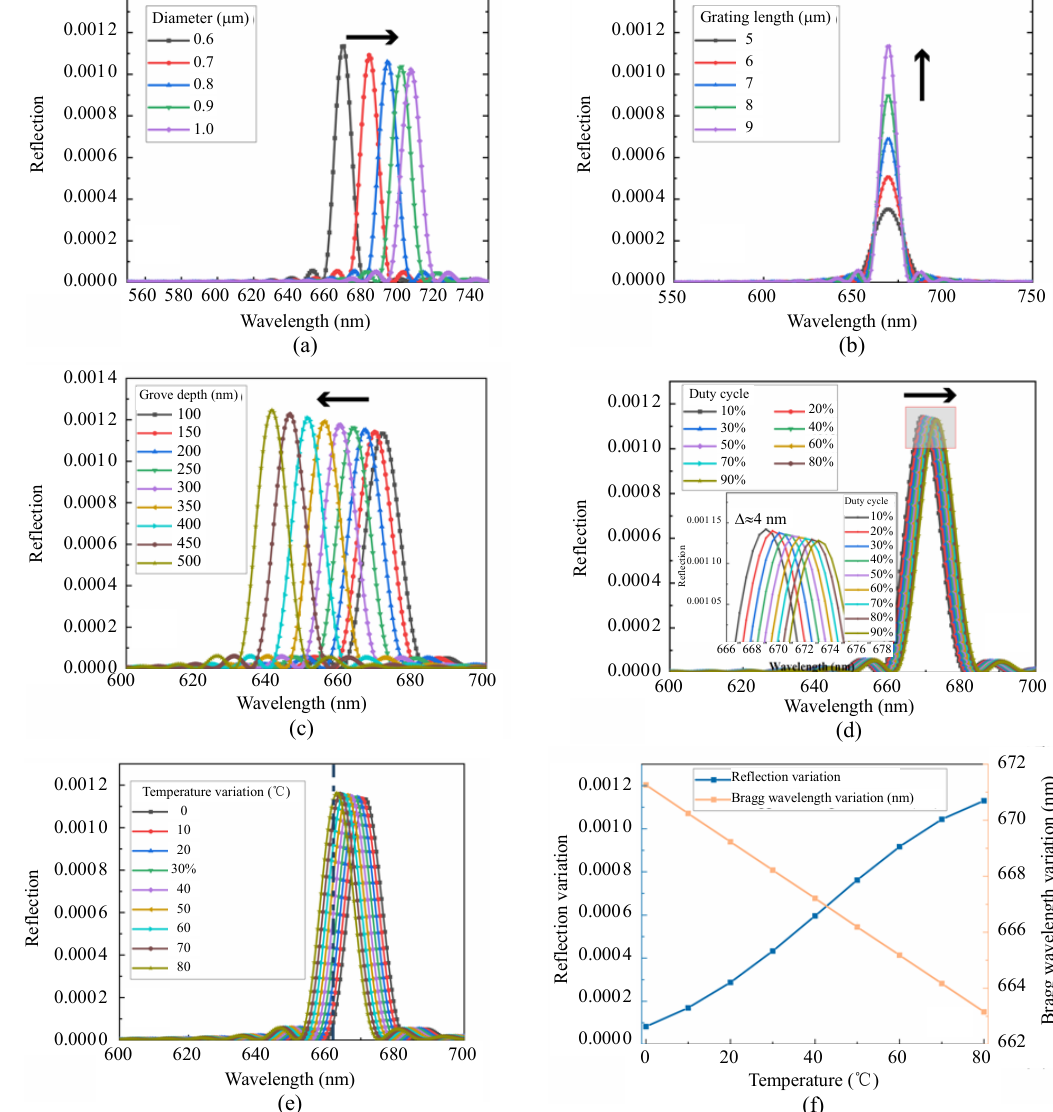
Fig. 2 Bragg wavelength shift of reflection spectrum with variation of (a) diameter, (b) grating length, (c) grove depth, (d) duty cycle, (e) temperature and (f) optical power variation of 661 nm and Bragg wavelength variation of Fig. 1 (e). The basic parameter setting here is diameter = 0.6 μm, grove depth = 100 nm, duty cycle = 50%, and grating length = 9